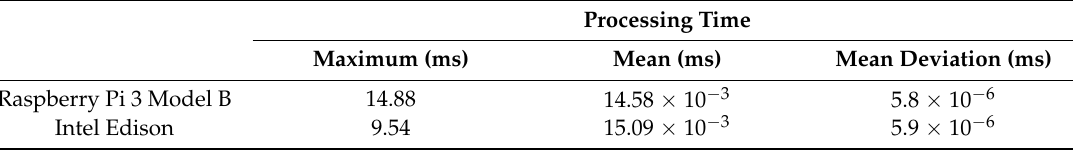
Table 8. Test 3. Processing time on Raspberry Pi 3 Model B and Intel